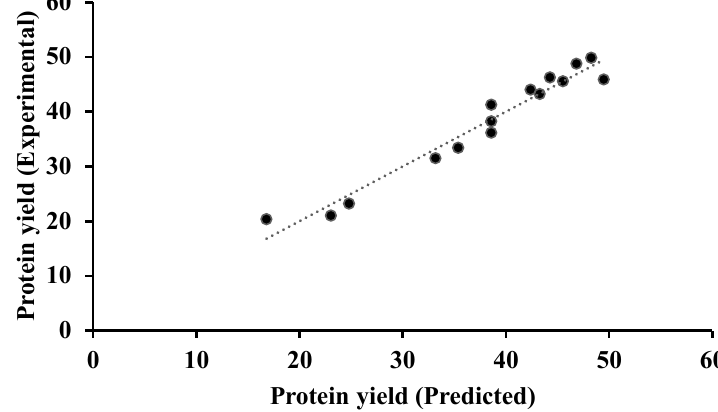
Figure 1. Protein yield (%) from experimental and predicted values.